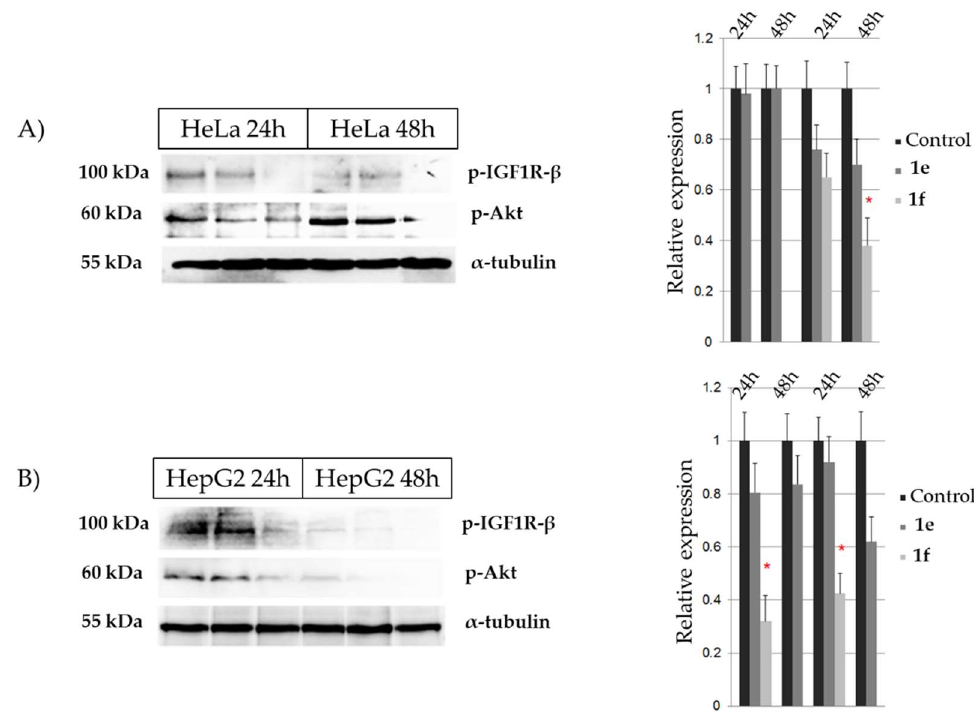
Figure 4. Representative membranes with IGF1R-β and pAkt signals in: ( A ) HeLa cells treated with compounds 1e and 1f for 24 h and 48 h. Relative expression is shown on the right panel as the average of three experiments ± standard error. ( B ) HepG2 cells treated with compounds 1e and 1f for 24 h and 48 h. Relative expression is shown on the right panel as the average of three experiments ± standard error. Statistically significant changes are marked with an asterisk (*).